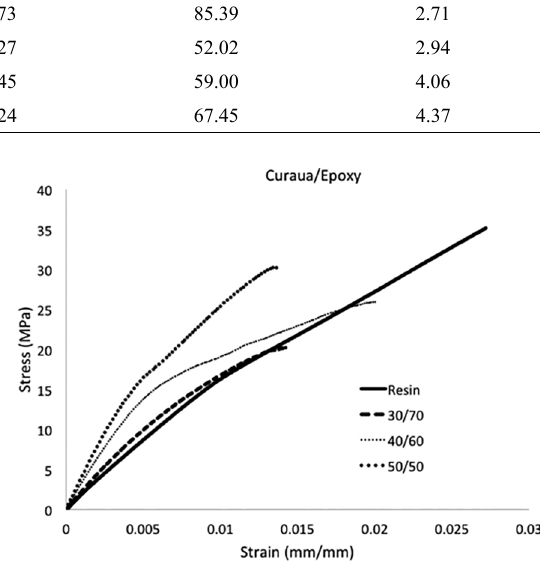
Figure 3. Typical tensile stress vs. strain curves of Curaua/Epoxy composites. Both modulus of elasticity and maximum strength are fiber-dependent. The stress-strain curve becomes